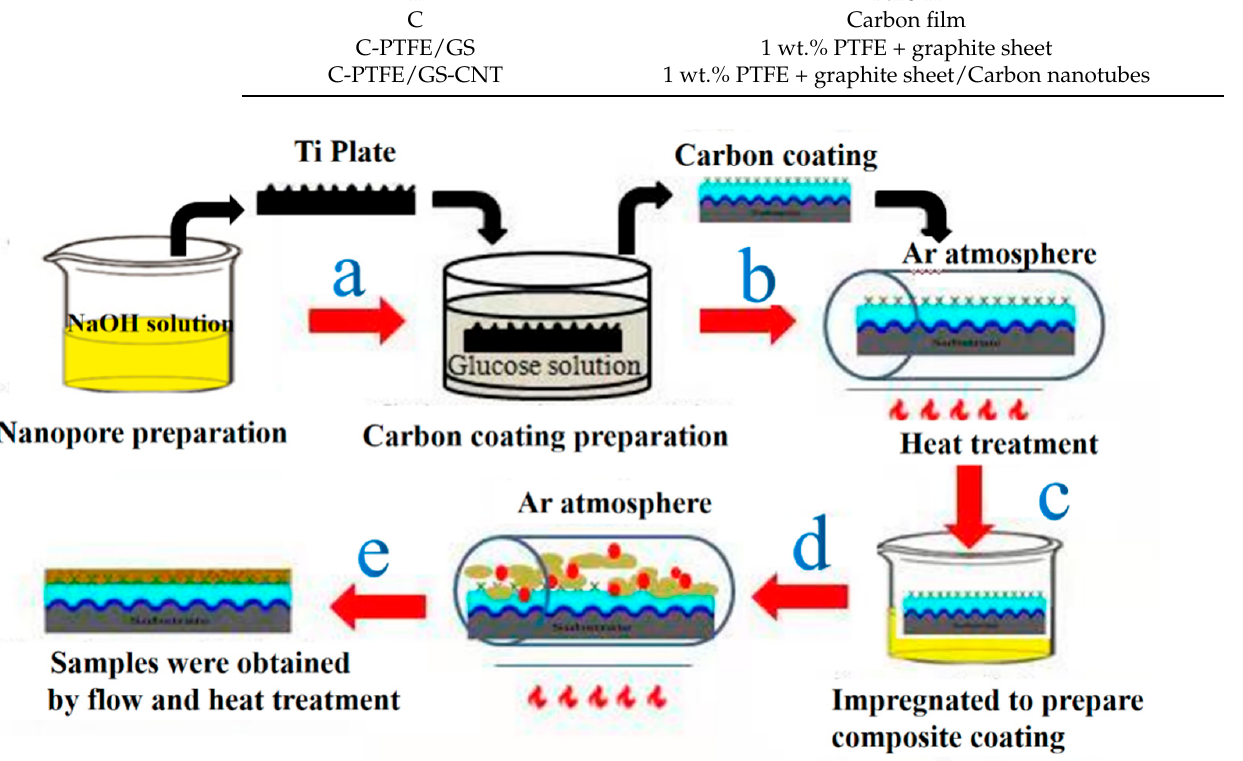
Figure 1. Illustration of preparation of composite coating on Ti substrate by the method of impregnation and hydrothermal.